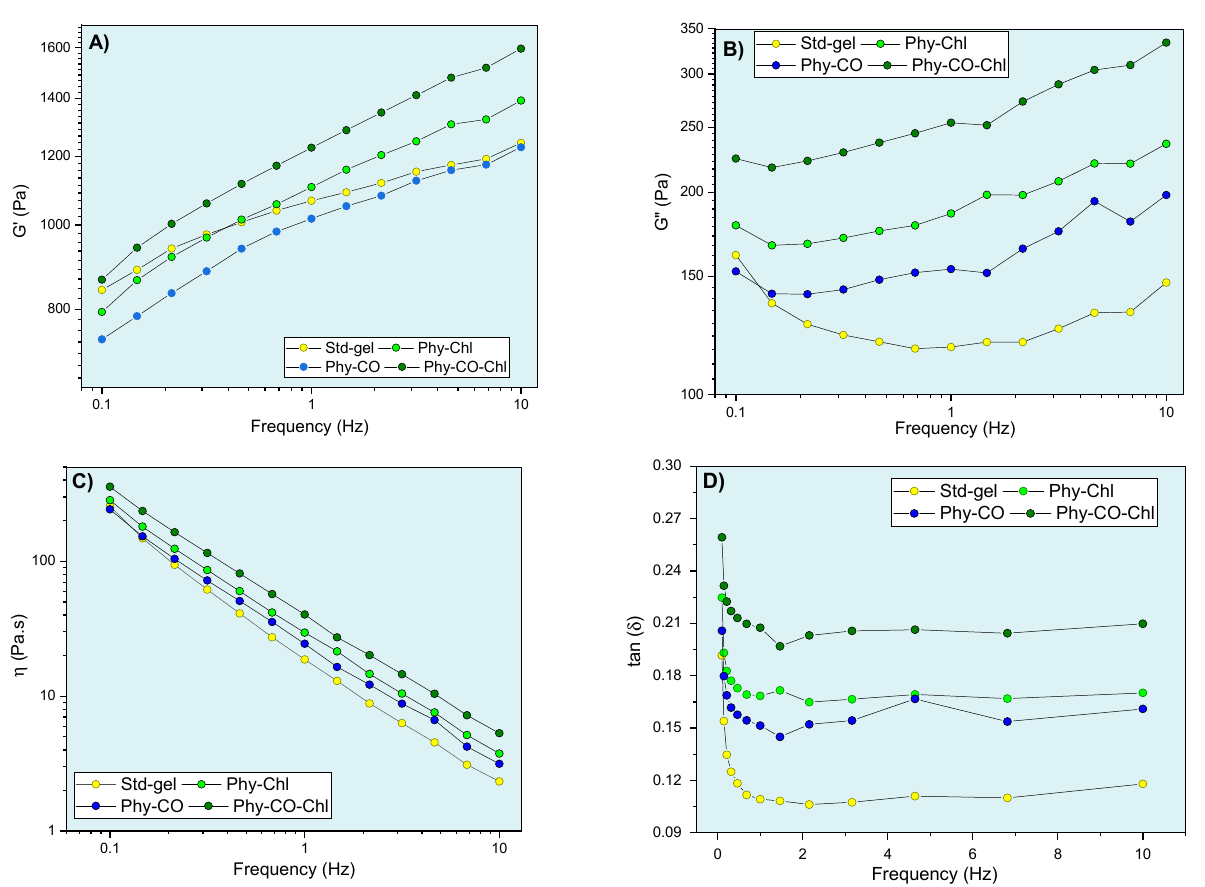
Figure 9. Gel oscillatory properties at 32.0 °C, being ( A , B ) G’ (elastic) and G” (viscous) moduli, ( C ) dynamic viscosity, and ( D ) viscoelasticity properties as a function of oscillatory frequency. The viscoelastic behavior was dependent on composition and frequency. The CO and Chls incorporation (Phy-CO and Phy-Chl) did not significantly affect the G’ modulus ( p > 0.05). On the other hand, the Phy-CO-Chl obtention increased the G’ modulus in a pronounced way, especially at the highest frequencies ( p < 0.05). The G” modulus showed slight increases in the following order: Std-gel, Phy-CO, Phy-Chl, and Phy-CO-Chl. Nev- ertheless, the increases were not statistically significant ( p > 0.05). The viscous moduli in- crease was of greater magnitude than the elastic moduli increase, thus enhancing the plas- tic characteristic of the formulations. An elastic deformation nature may be related to drug/copolymer interaction, while plastic deformations may be related to changes in the helical conformation of the k- car biopolymer. The dynamic viscosity was reduced with small movements (low oscillatory frequencies). However, above 6 Hz, the variation was less pronounced. The gel composition did not cause significant changes in the dynamic viscosity ( p > 0.05). The tangent loss, expressed as tan δ (G”/G’), decreased with the oscillatory frequency increase ( p < 0.05) for all systems. The enhanced viscoelasticity followed the complexity of the matrix composition, where Phy-CO-Chl showed tan δ of 0.259, a nearly two-fold in- crease compared with that of Std-gel. All formulations had tan δ values lower than one (Figure 9D), and were classified as viscoelastic systems. This is an essential property when considering drug-delivery systems, as it suggests an appropriate retention of these for- mulations at the application site [63,69–74]. 3.3. Photodynamic Inactivation of Staphylococcus Aureus Bacterial Wound healing involves three major phases: inflammatory reaction, cell prolifera- tion, and remodeling. First, the inflammatory process occurs with vasoconstriction, he- mostasis, and inflammatory mediator release. Then, the granulation tissue is triggered, with fibroblast proliferation and angiogenesis effects. At this point, opportunistic patho- gens, such as Staphylococcus , infect small dermal lesions and invade subcutaneous tissue [46,75,76]. Therefore, inactivation studies of these pathogens are fundamental to evaluate the healing and antibiotic potential of the drug. The antibacterial activity of Phy-gels against S. aureus is presented in Figure 10.